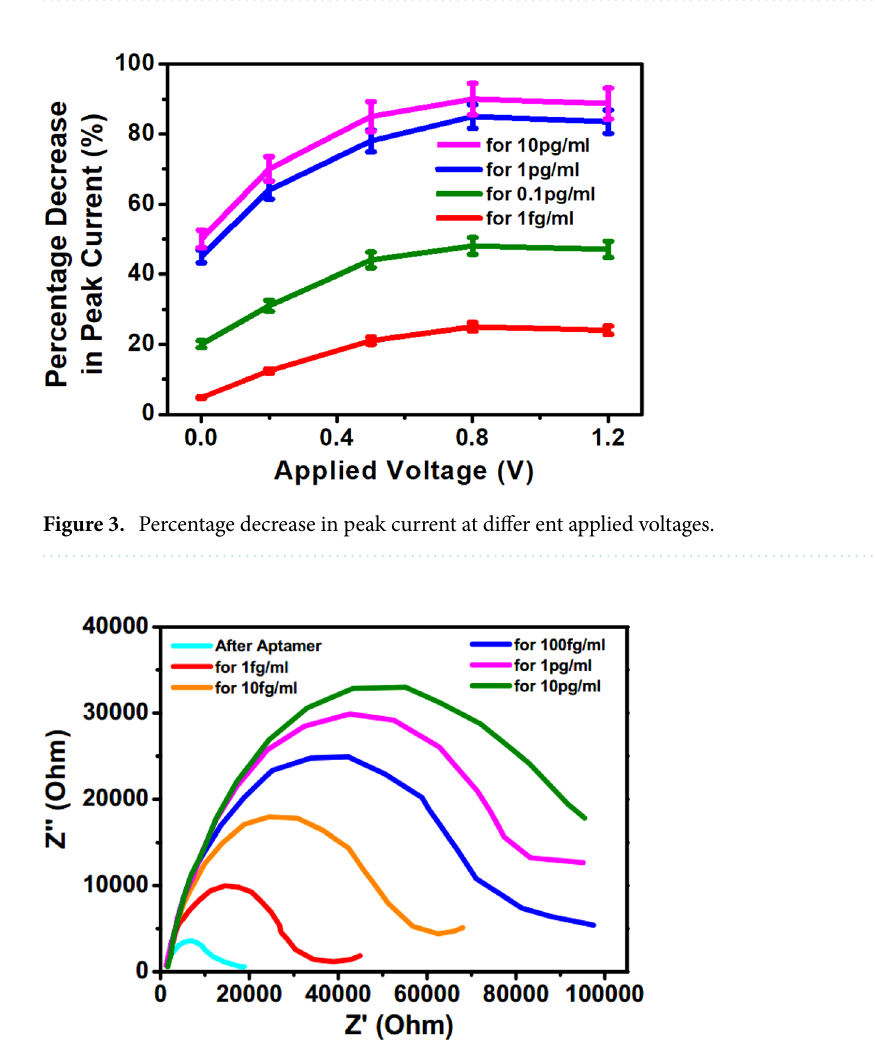
Figure 4. EIS of Graphene ZnO sensor electrode before and after capture of 1 fg/ml to 10 pg/ml of CEA with external pulses of + 0.8 V. (graph indicates mean values with maximum standard deviations of ±